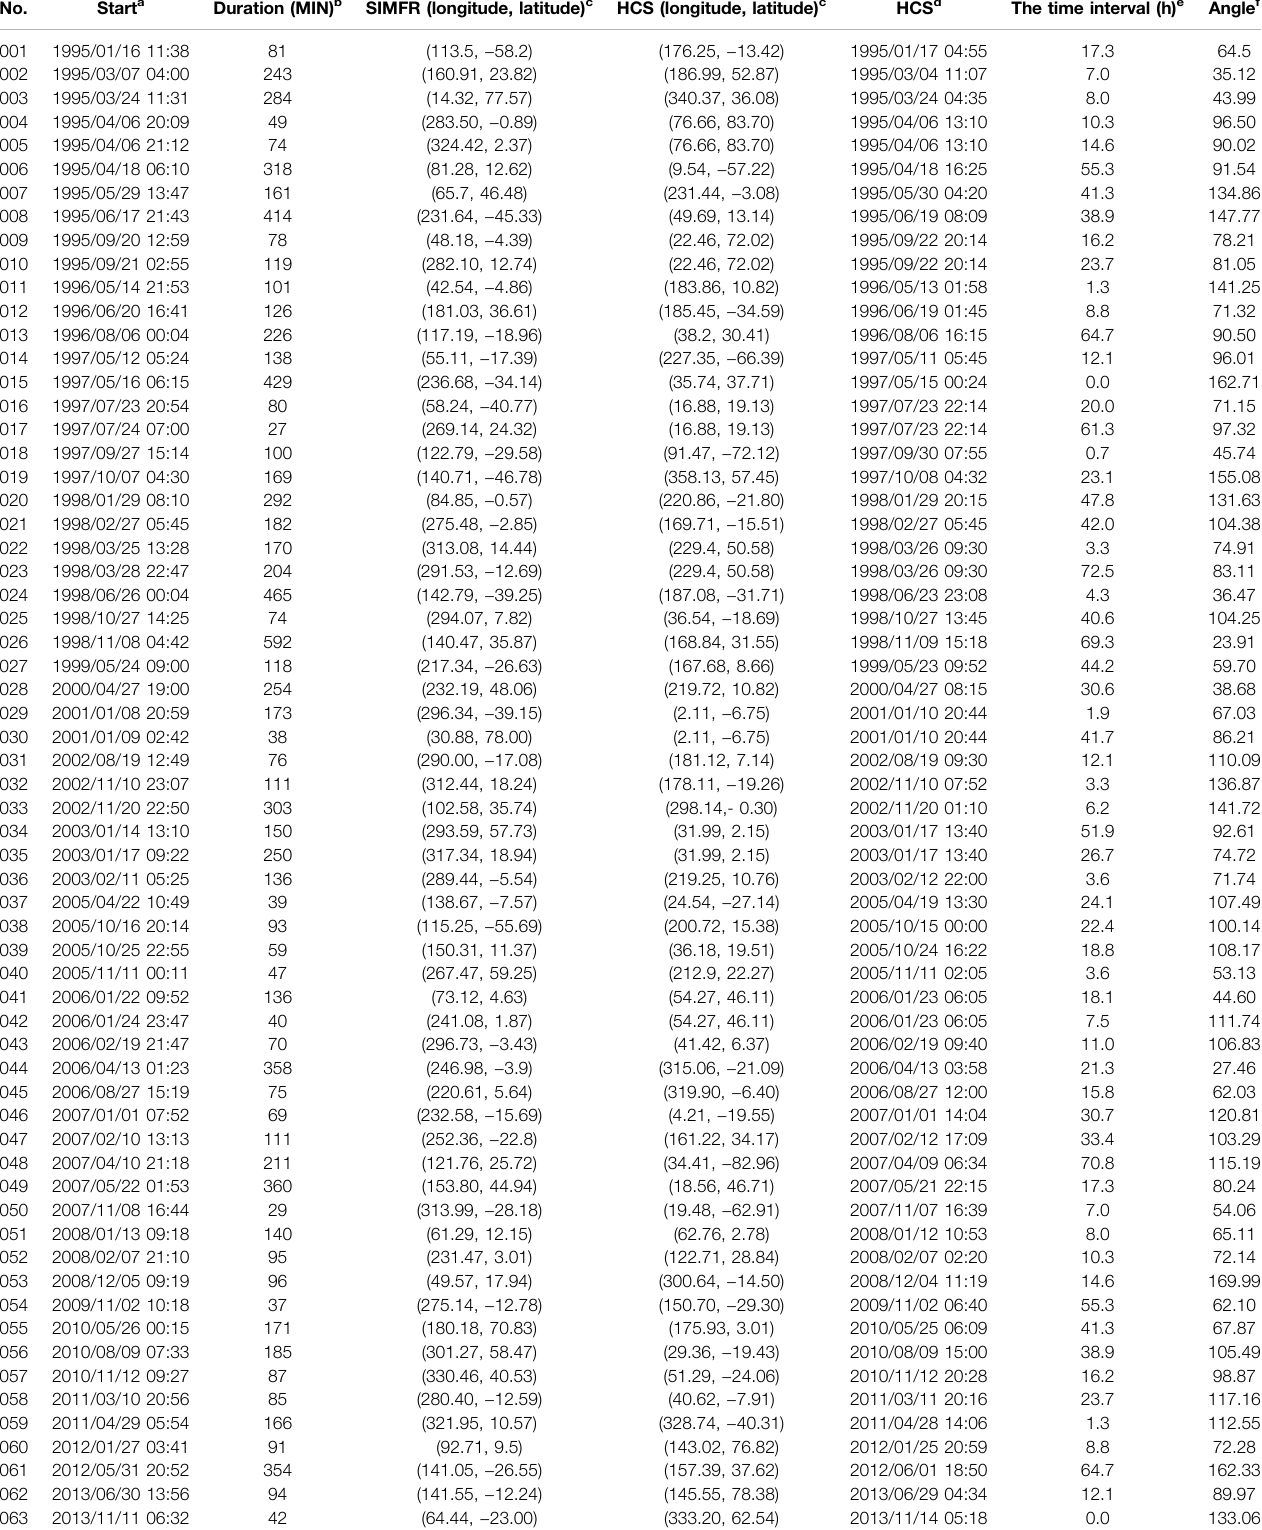
TABLE 1 | The list of SIMFR studied in this